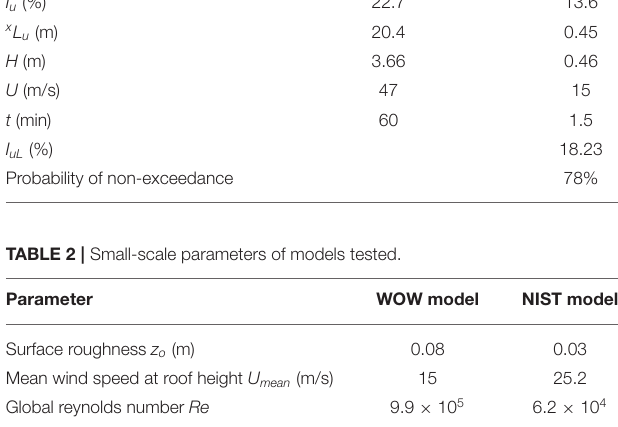
using MATLAB R (cid:13) (2019) software and then area-averaged peak pressure coefficients were obtained according to Equation 6.